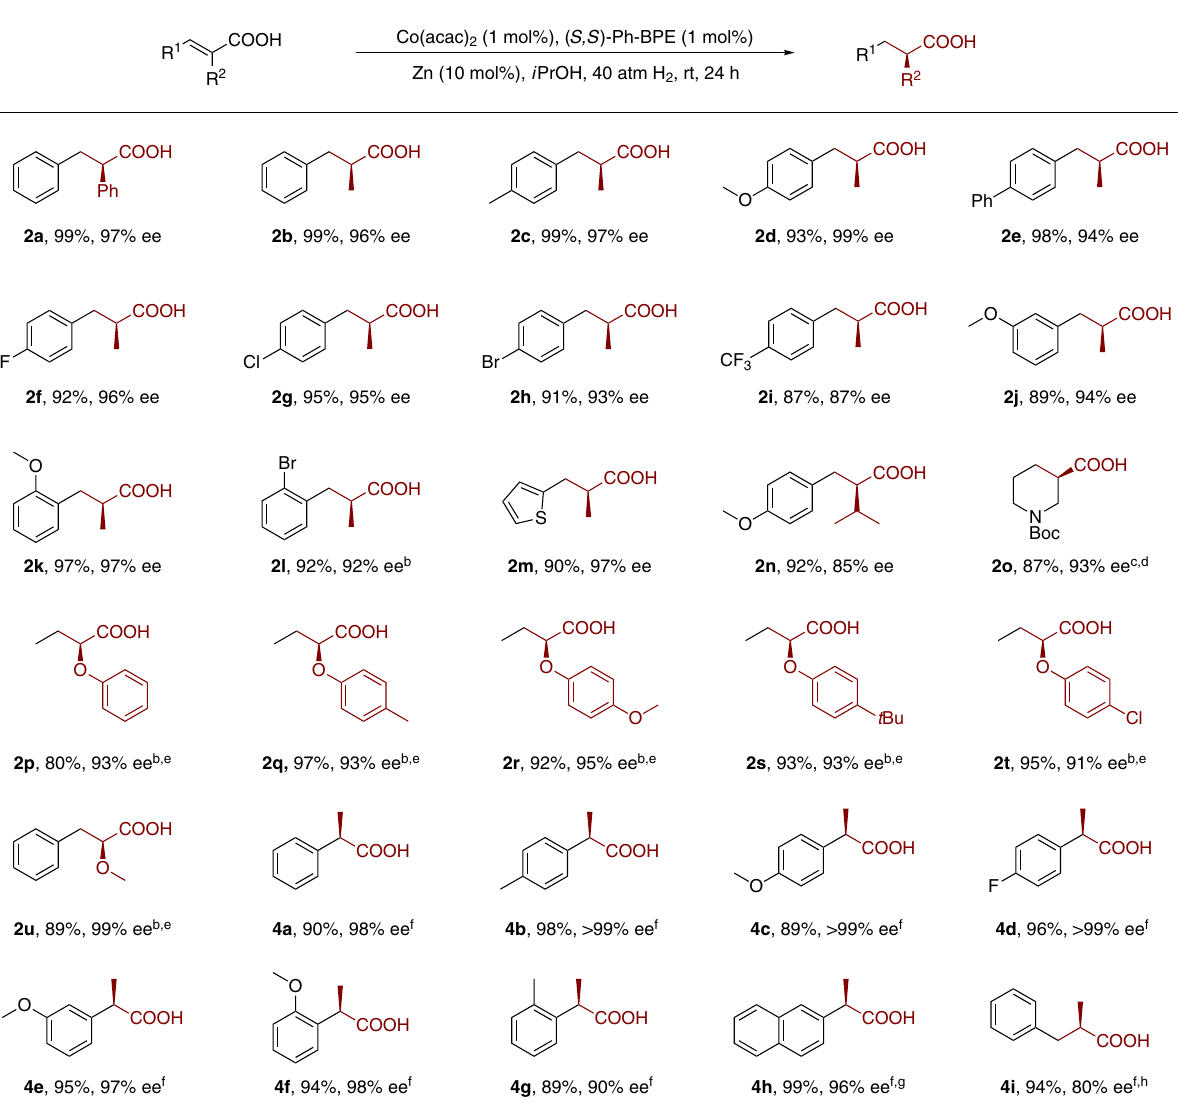
Fig. 4 Cobalt-catalyzed asymmetric hydrogenation of various α , β -unsaturated carboxylic acids. a Conditions: 1 (0.1 mmol), Co(acac) 2 (1 mol%), ( S , S )- Ph-BPE (1 mol%) and Zn (10 mol%) in i PrOH (0.6 mL) under 40 atm H 2 pressure at room temperature for 24 h. Yield of isolated products, unless noted otherwise. The ee values were determined by HPLC analysis. b Under 60 atm H 2 pressure, 50 °C. c Under 80 atm H 2 pressure, 50 °C. d With 5 mol% of Cat. S , S )-Ph-BPE in MeOH (0.4 mL), 72 h. f 3 (0.1 mmol), CoCl S , S )-Ph-BPE (5 mol%), and Zn (50 mol%) in HFIP e With 5 mol% of CoCl 2 and ( 2 (5 mol%), (